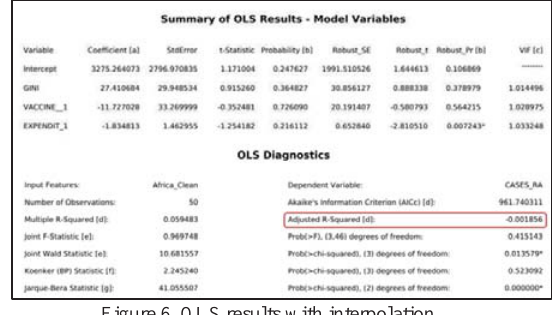
Figure 6. OLS results with interpolation